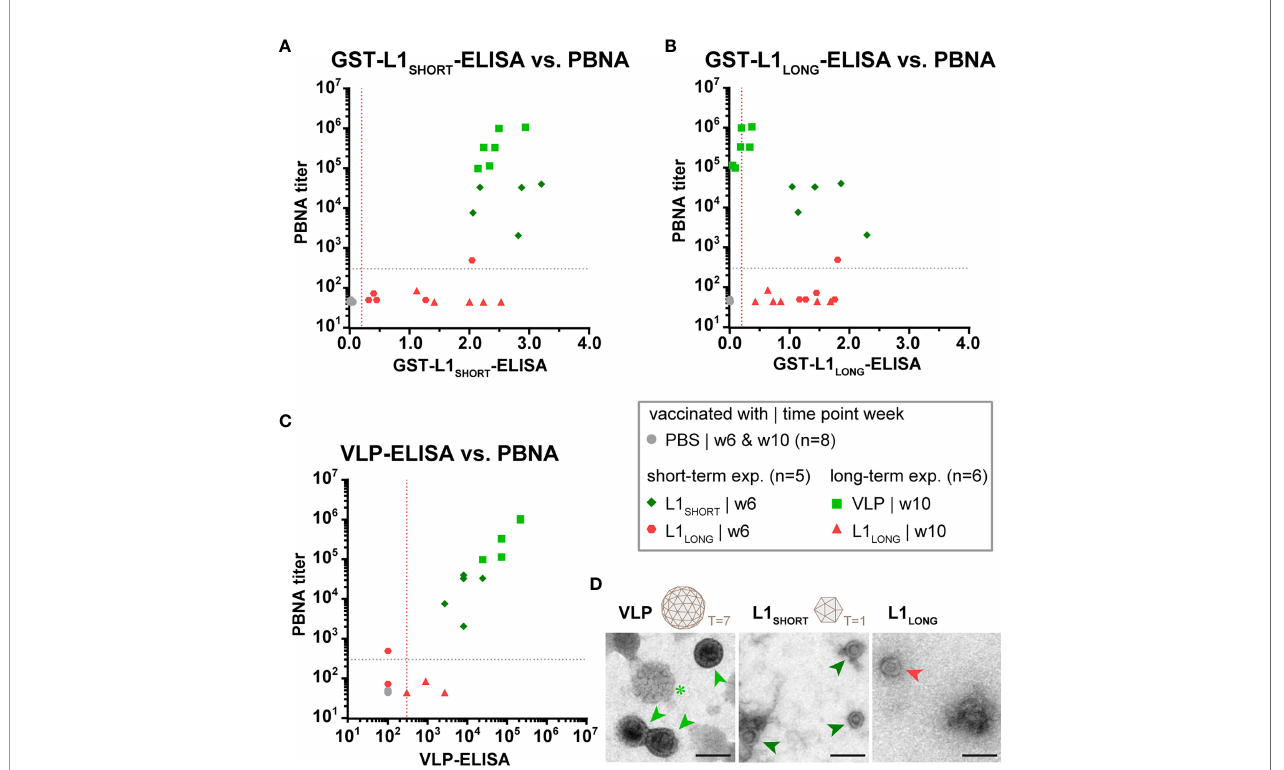
FIGURE 3 | Only vaccination with L1 SHORT but not L1 LONG induces neutralizing antibodies. Correlation of data from (A) L1 SHORT -GST-ELISA and PBNA, (B) L1 LONG - GST-ELISA and PBNA, (C) VLP-ELISA and PBNA. Animals were vaccinated with MnPV VLPs (green squares, long-term experiment, n = 6 animals), MnPV L1 SHORT (dark green rhombus, short-term experiment, n = 5 animals see also Supplementary Figure S1 ), MnPV L1 LONG (red triangles, long-term experiment, n = 6 animals; red hexagons, short-term experiment, n = 5 animals, see also Supplementary Figure S1 ) or PBS (grey dots, long-term experiment, n = 6 animals). Dashed lines represent the methods ’ cut-off (OD 450 = 0.2 for GST-ELISA or titer of 300 for VLP-ELISA and PBNA). (D) Morphology of different L1 antigen preparations (VLPs, L1 SHORT , L1 LONG ) by negative stain electron microscopy at 16,000x magni fi cation (scale bar: 50 µm). Schemes depict 72-pentamer (T = 7) and 12-pentamer (T = 1) particles as previously described